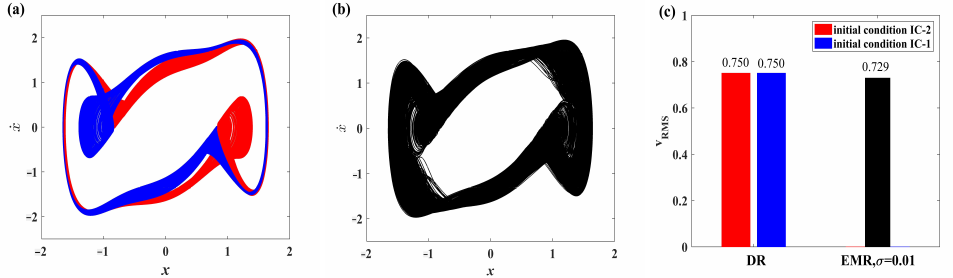
Figure 6. DR and EMR ( σ = 0.01) for ζ =0.9. ( a ) Phase portraits of DR; ( b ) Phase portraits of EMR ( σ = 0.01). ( c ) RMS voltage of DR and EMR ( σ = 0.01). The blue dots and red dots are obtained under the initial conditions (IC-1) and (IC-2), respectively.